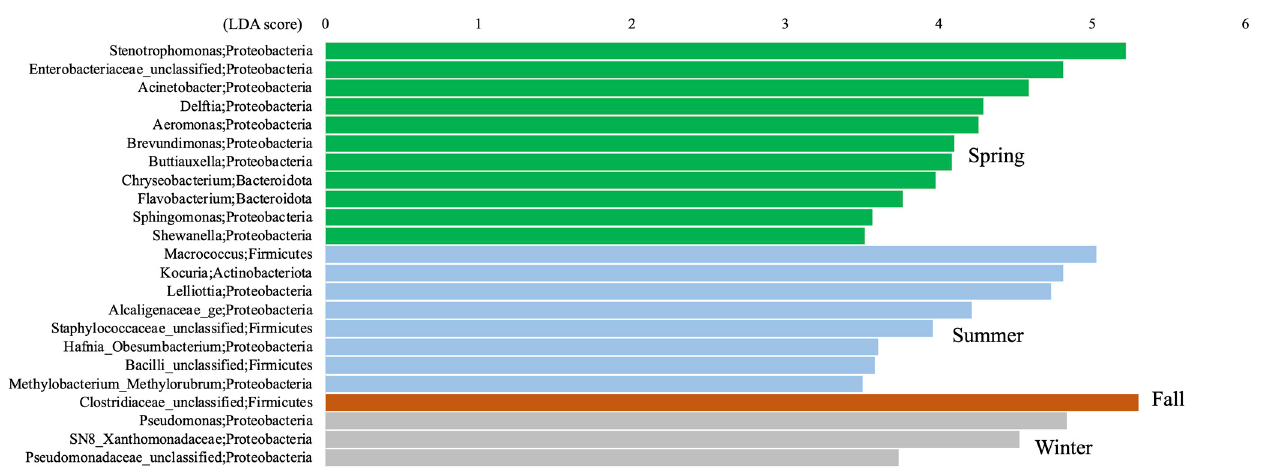
Figure 3. Linear discriminant analysis (LDA) score comparing significantly different gut microbiome bacterial genera between the four tested seasons, calculated using the LEfSe analysis. Genera with a LDA score > 3.5 are displayed.